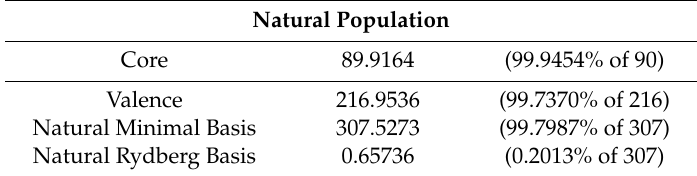
Table 5. Natural bond orbital of CQD with 10 rings using CAM-B3LYP methods.